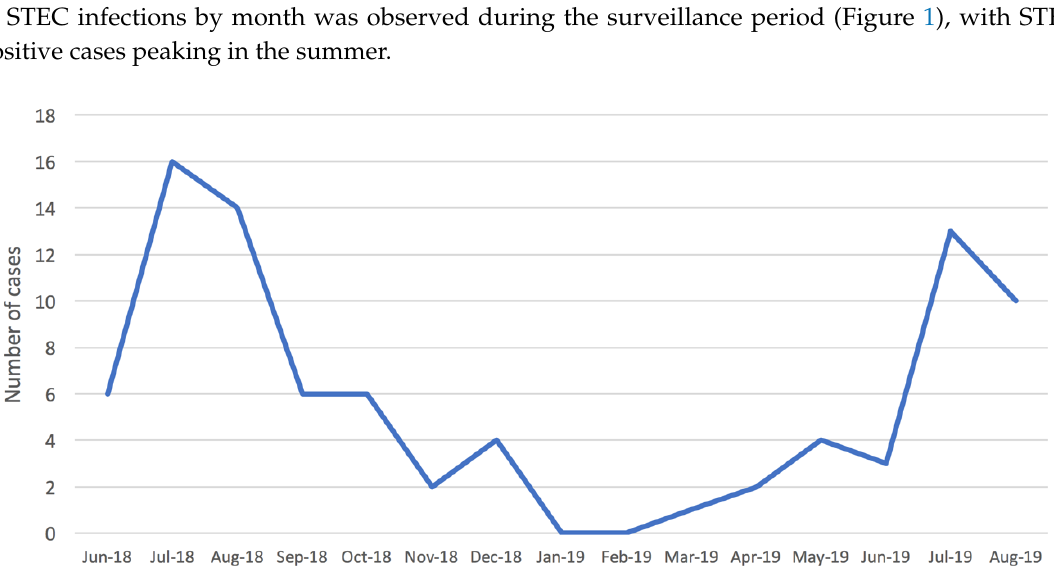
Figure 1. Distribution of confirmed cases of Shiga toxin-producing Escherichia coli (STEC) infection in children (<15 years old) by month, Apulia region, June 2018–August 2019.